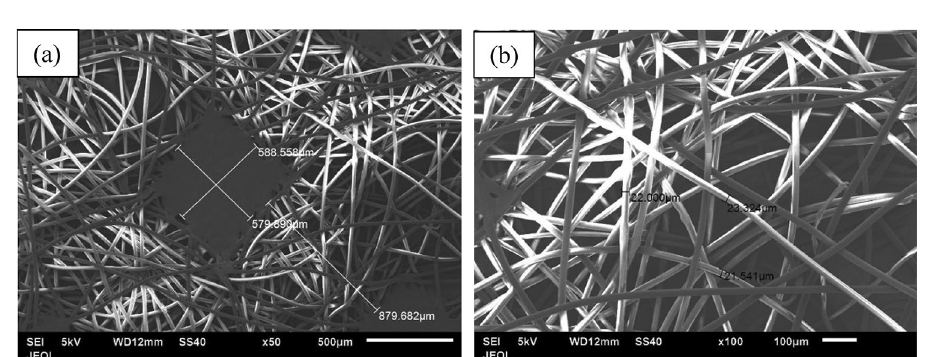
Figure 11. Fibers configuration of the third layer (white) of the facemask; ( a ) showing the hollow square of the fibers and ( b ) the diameter of each fiber magnified 100